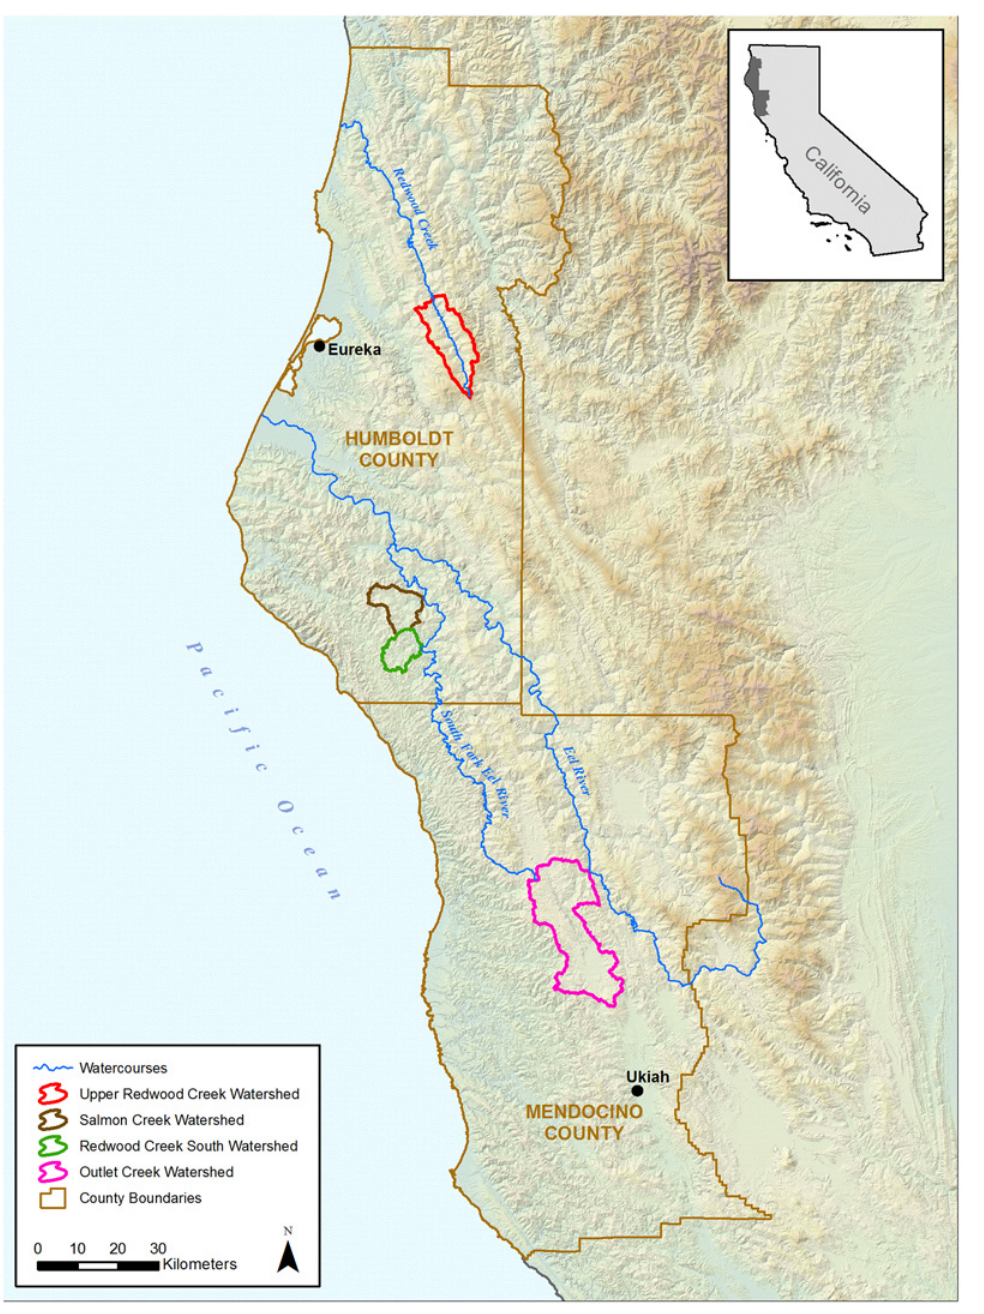
Fig 1. Study Watersheds and Major